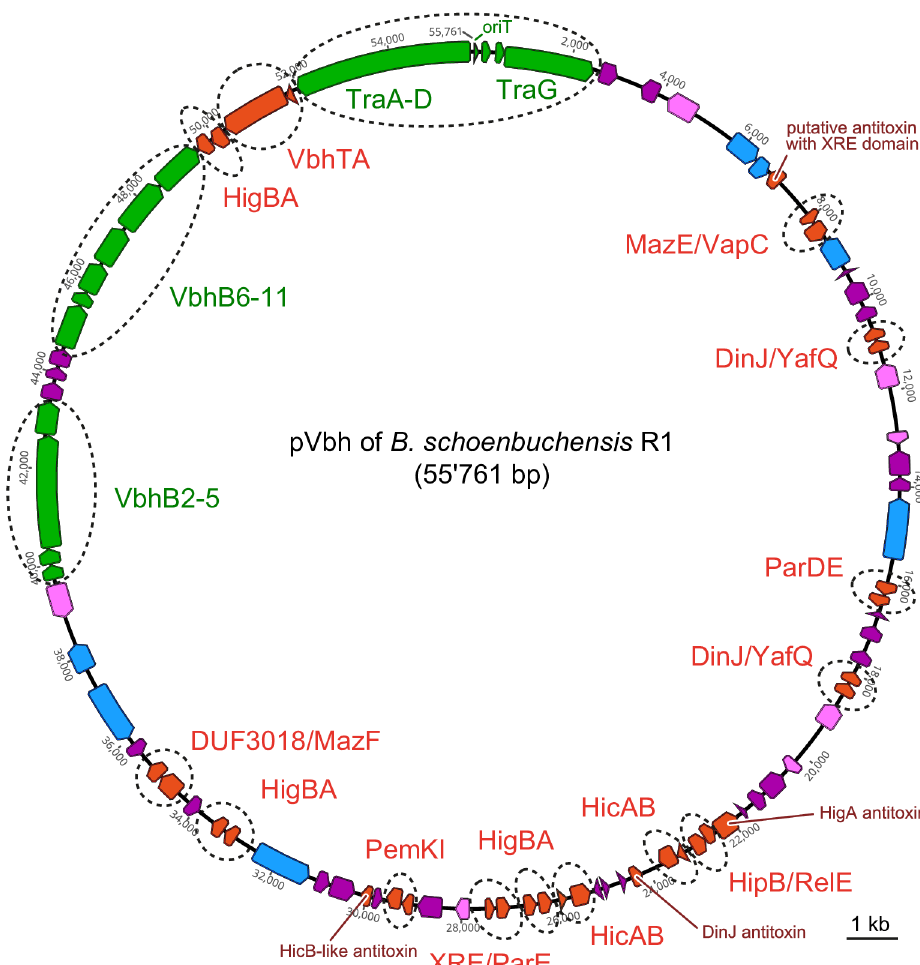
Fig 3. pVbh encodes a multitude of TA modules but lacks any recognizable cargo genes. All geneson pVbh of B . schoenbuchensis R1 (genbankaccessionnumberCP019790.1) were manuallyannotatedand categorized as belonging to the Vbh conjugation system (green; see also Fig 2), plasmidreplicationand partitioningfunctions (light blue), TA modules(red), or as encoding proteins of unknownfunction with (light pink) or without (dark pink) known protein domains.The fourteen predicted TA modulesand four orphan antitoxinsas well as the loci encodingthe Vbh T4SS (VbhB2-11),Dtr functions (TraA-D), and T4CP (TraG) were highlightedin detail. Annotations of every gene on pVbh are availablein S1